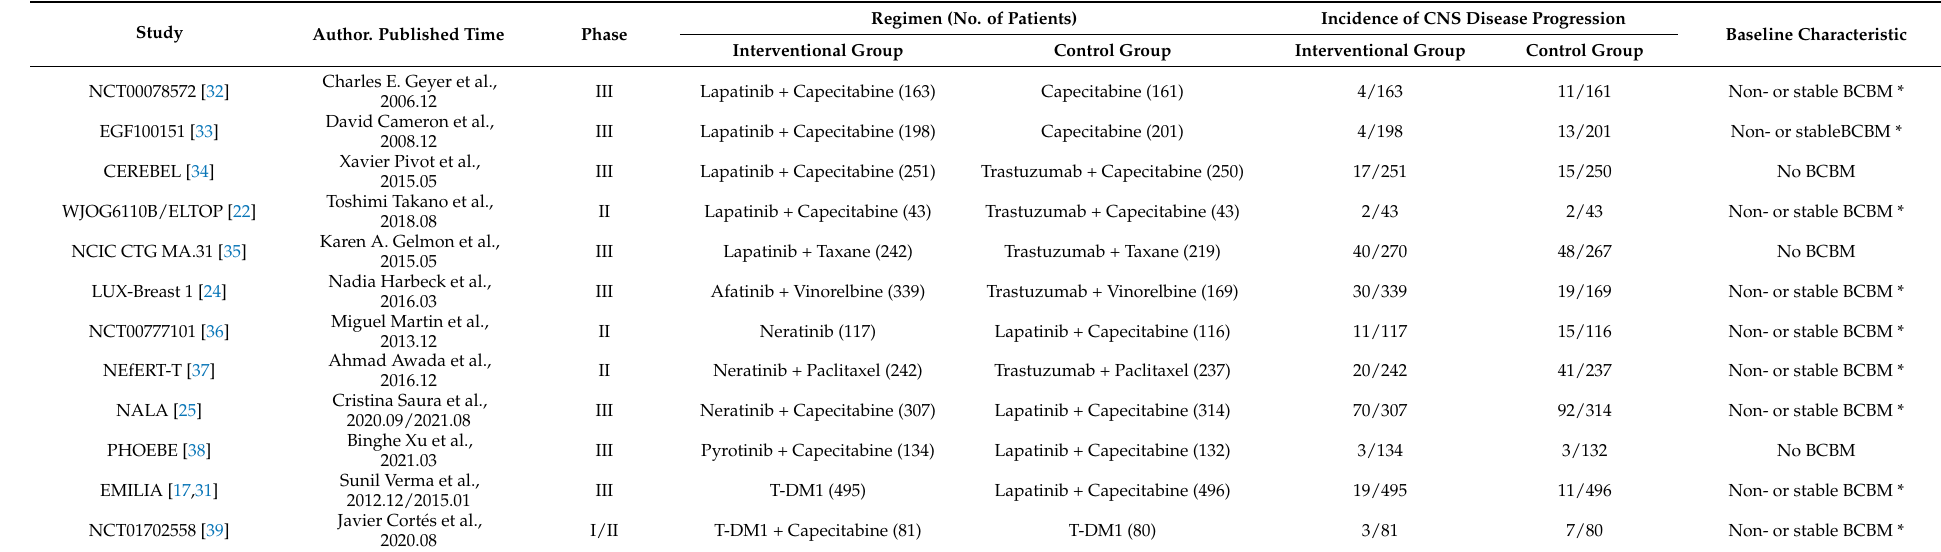
Table 2. The baseline characteristics and the recurrent outcomes of CNS of the included